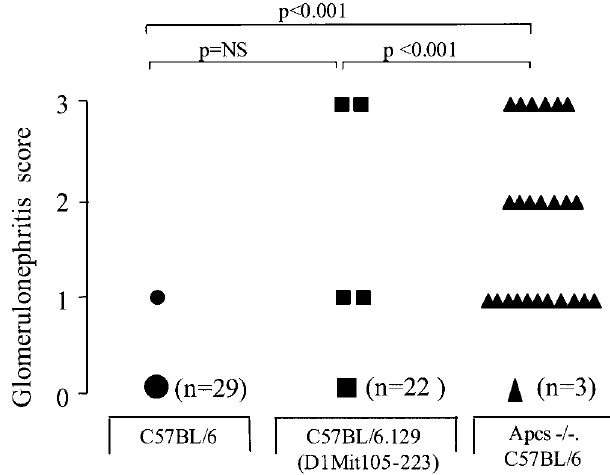
Figure 9. Renal Histological Assessment C57BL/6 mice, C57BL/6. Apcs (cid:1) / (cid:1) mice, and C57BL/6.129(D1Mit105– 223) congenic mice were sacrificed at 1 y of age to obtain age- matched autopsy specimens. Bouin’s fixed kidney sections were scored blinded for glomerulonephritis . Glomerulonephritis was graded on a 0–3 scale (see Materials and Methods for details). DOI: 10.1371/journal.pbio.0020243.g009 PLoS Biology |